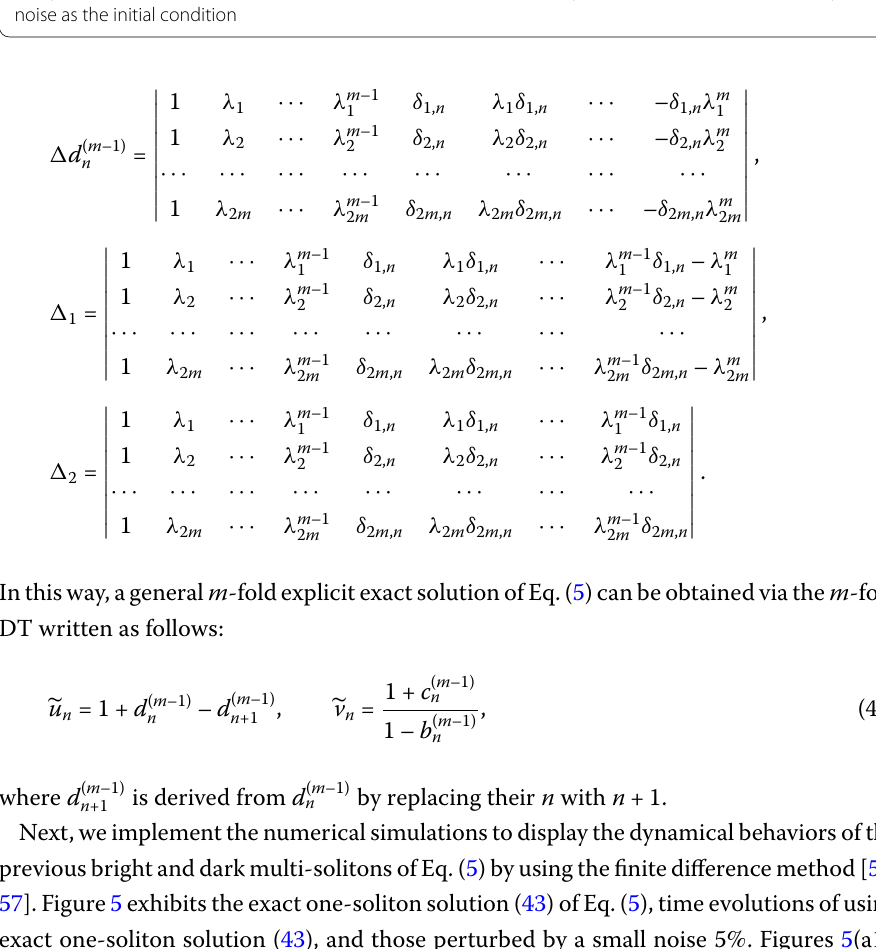
Figure 5 One-soliton solution (43) with the same parameters as Fig. 2. ( a ) Exact solution; ( b ) Time evolution using exact solution (43) as an initial condition; ( c ) Time evolution using exact solution (43) perturbed by a